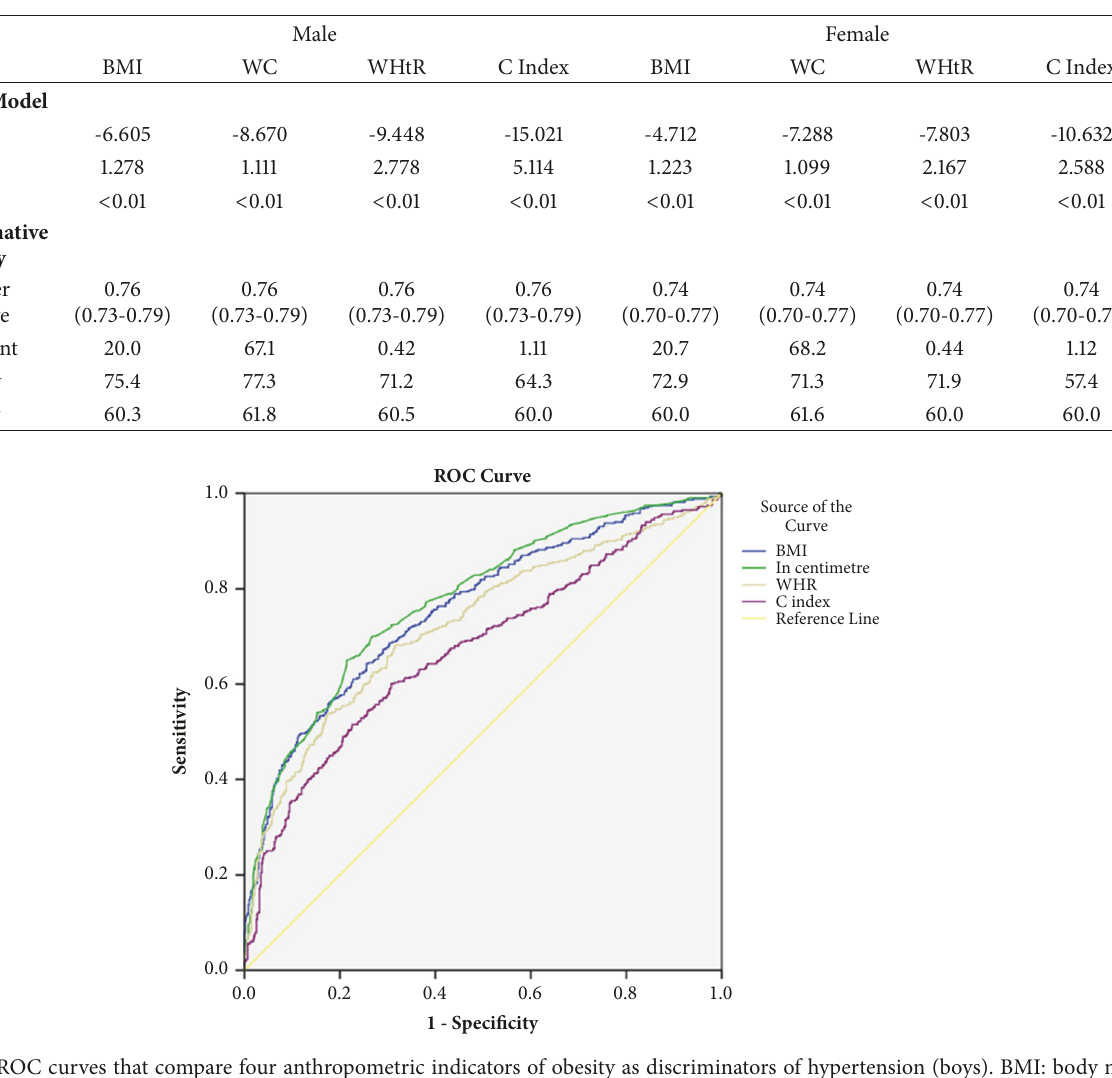
Table 3: Age-adjusted Logistic regression model and discriminative capability for hypertension by sex (N=2461).